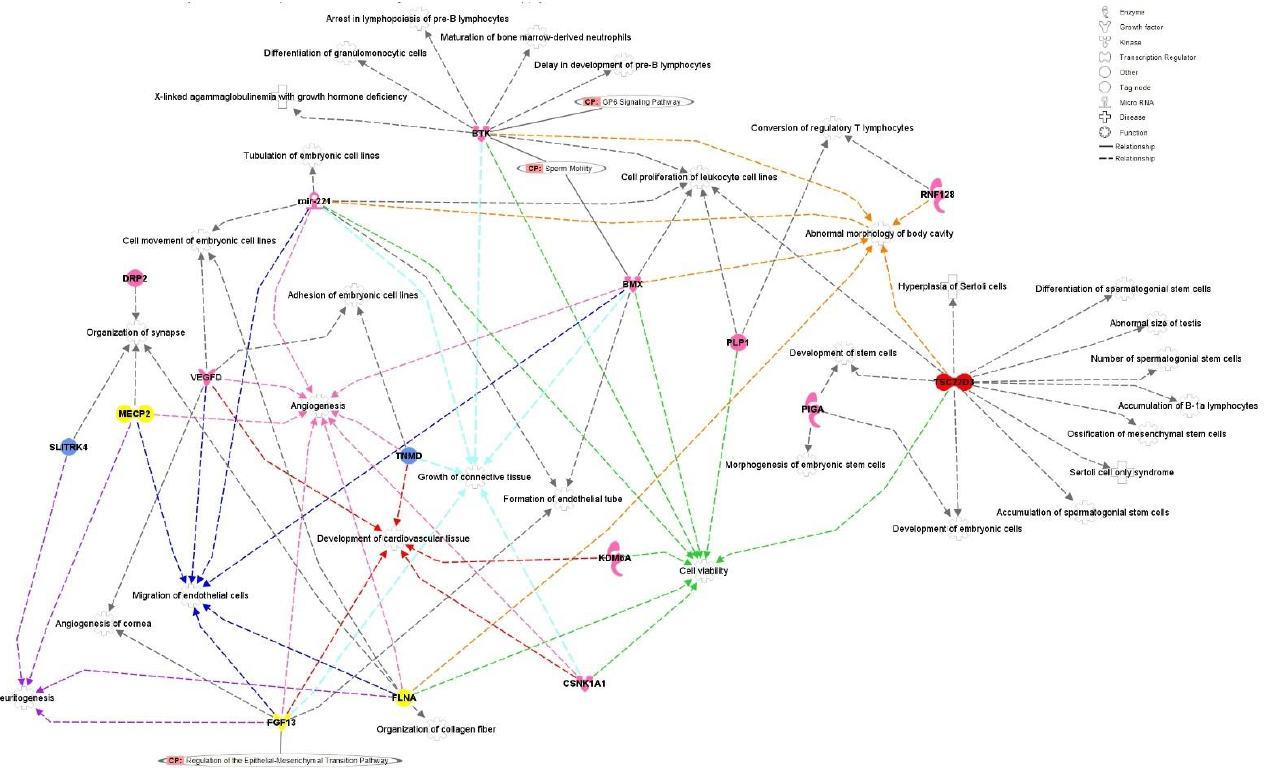
Figure 5. Interaction network between the positional candidate genes around TRD regions on bovine X-chromosome and biological functions and diseases identified. For the most relevant biological functions, the edges between the genes and the processes were colored in order to highlight the connection. These biological functions were: cell viability (green), angiogenesis (pink), development of cardiovascular tissue (red), migration of endothelial cells (blue), growth of connective tissue (cyan), abnormal morphology of body cavity (orange) and neuritogenesis (purple). The positional candidate genes were colored in function of the predominant (highest |α|) TRD observed for the associated marker, where: pink represents dam-TRD among in heterosomal regions (RNF128, PIGA, PLP1, BMX, KDM6A, CSNK1A1, VEGFD, DRP2 and bta-mir-221); yellow represents male- and female-dam-TRD in heterosomal regions (FLNA, FGF13 and MECP2); blue represents recessive TRD pattern in heterosomal regions (TNMD, SLITRK4 and BTK). The gene TSC22D3 was colored in red because two different TRD patterns were observed for the markers mapped in the interval used to annotate the gene. These TRD patterns were dam-TRD and recessive-TRD, both in heterosomal regions.